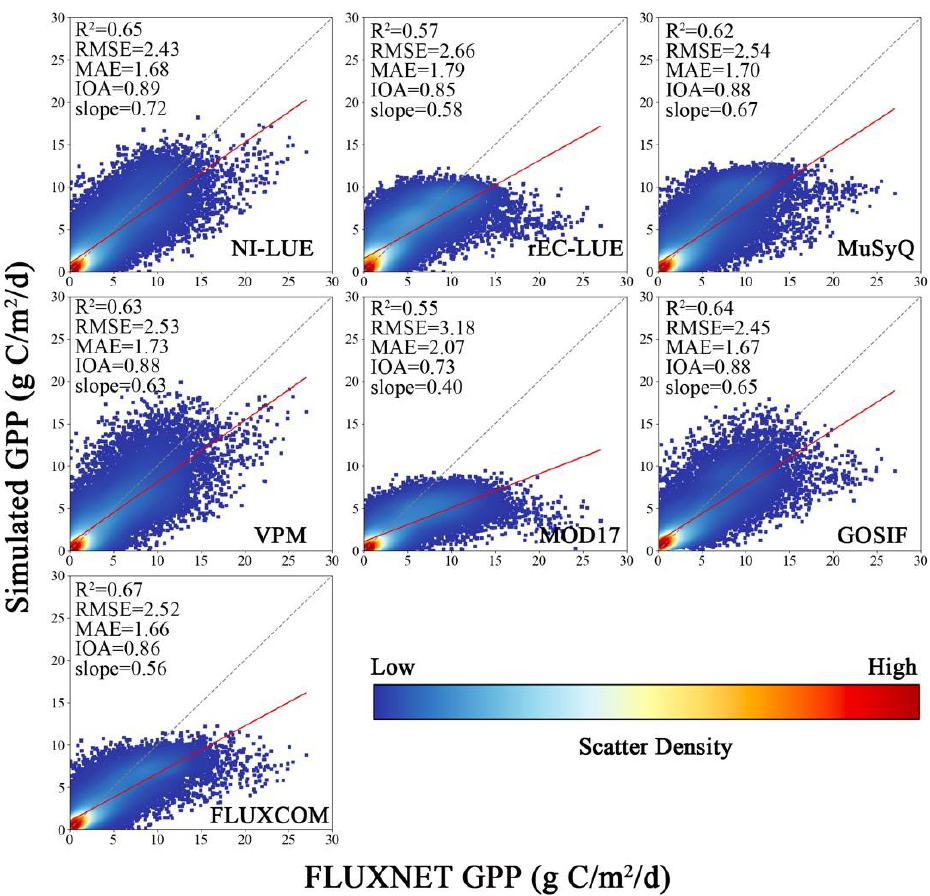
Figure 10. Comparisons between FLUXNET GPP and various GPP products at 8-day time scales. Dashed lines are 1:1 lines. Red solid lines are linearly-fitted lines.